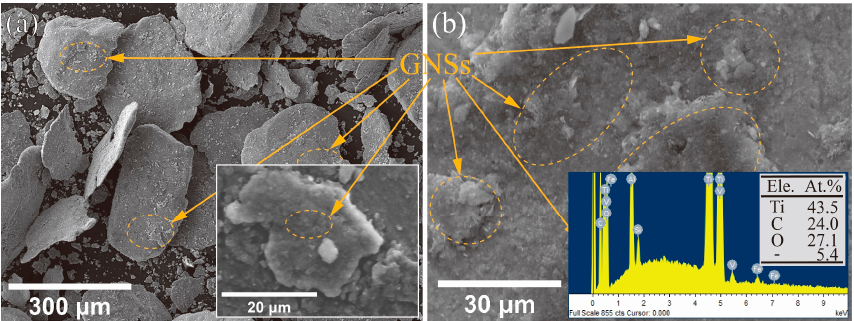
Figure 10. SEM images of #3 GNS/Ti64 composite powders ( a ) via three-dimensional BM and a magnified powder surface ( b ).